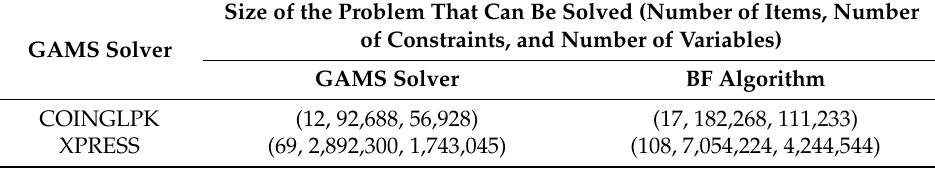
Table 8. Summary of the results for the maximum problem size